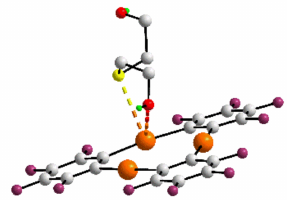
Figure 1. Supramolecular association in the crystal comprising tris( µ 2 -perfluoro-o-phenylene)-tri- mercury bis(2-hydroxyethyl)sulphide (1:1) whereby the constituent molecules are assembled into a zero-dimensional aggregate, connected by both Hg ··· S and Hg ··· O contacts shown as orange/yellow and orange/red dashed lines, respectively. The colour code for this and subsequent diagrams: orange—mercury; yellow—sulphur; plum—fluoride; red—oxygen; grey—carbon; green—hydrogen. Non-acidic hydrogen atoms are removed for